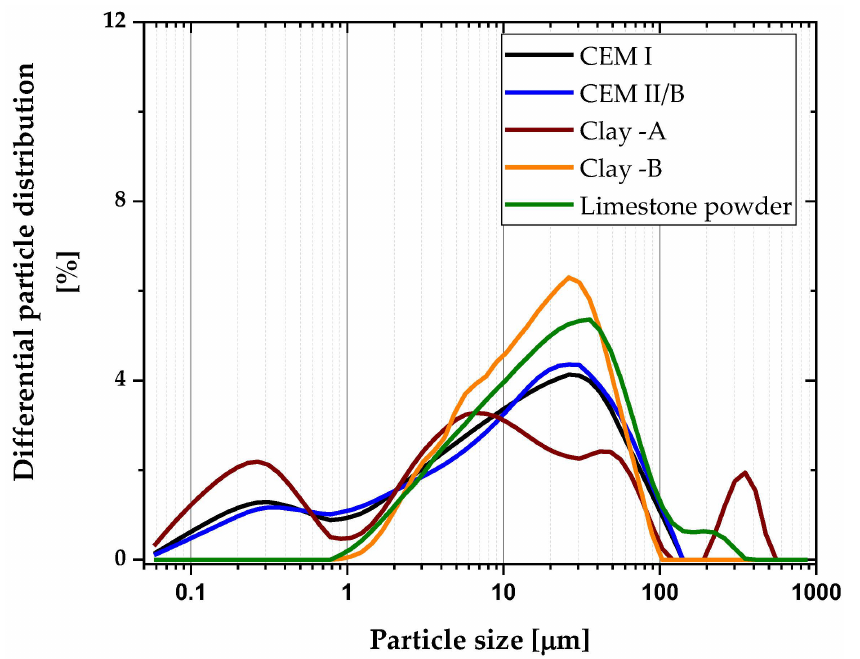
Figure 3. Particle size distribution of all materials used in this study. Table 3. Physical properties of aggregates used in this study.